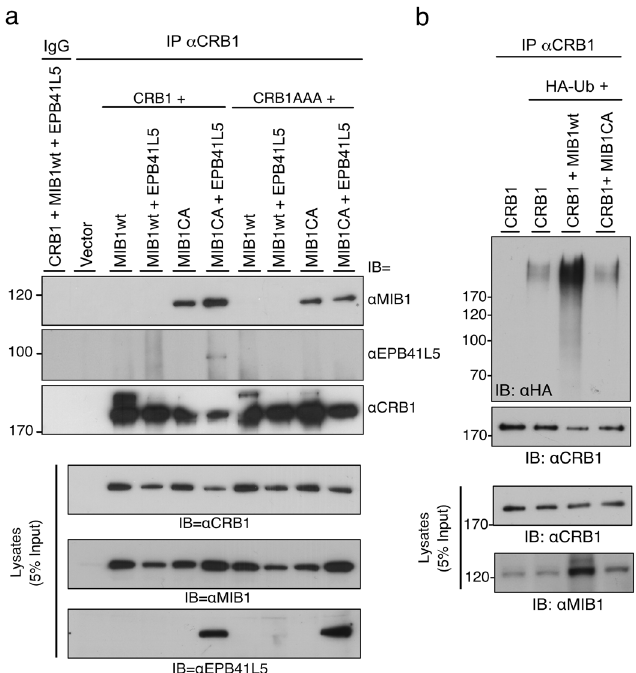
Figure 7. Apical polarity protein CRB1 is associated with and ubiquitinated by MIB1. ( a ) CRB1 co- immunoprecipitates with MIB1. Co-immunoprecipitation experiments were performed on lysates from HEK293T cells co-transfected with WT or mutant constructs of CRB1 and MIB1. CRB1AAA represents a mutant construct where the FERM domain binding motif of CRB1 is mutated thereby abolishing its binding to EPB41L5. The panels below (Lysates) show the relative expression of CRB1, MIB1 and EPB41L5 constructs in cell lysates. The MIB1CA ligase dead mutant bound to CRB1 and binding was enhanced in the presence of EPB41L5. ( b ) CRB1 is a substrate for MIB1-mediated ubiquitination. HEK293T cells were transiently co-transfected with myc-CRB1, HA-ubiquitin and either T7-MIB1WT or the ligase mutant T7-MIB1CA. Equivalent amounts of protein lysates were immunoprecipitated with anti-CRB1 and immunoblotted with anti-HA to detect ubiquitinated proteins. Lysates (5% of that used for immunoprecipitation) were immunoblotted with anti-CRB1 and anti-MIB1 to confirm protein expression. For clarity, blots were cropped. The full length blots are shown in Supplementary Fig.